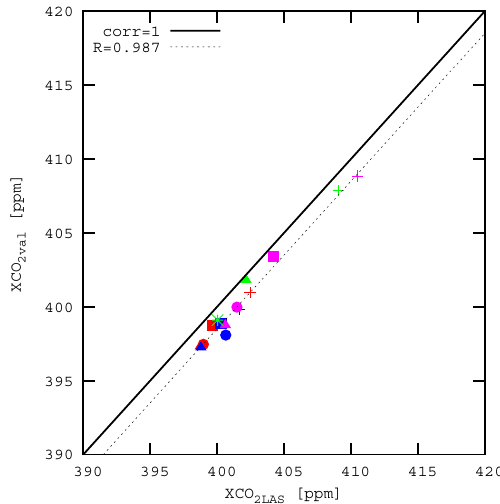
Fig. 9. Evaluated partial column-averaged column CO 2 (XCO 2LAS ) obtained from LAS (left panel) and the difference compared with calculated values (XCO 2val ) from flask and in situ measurements (right